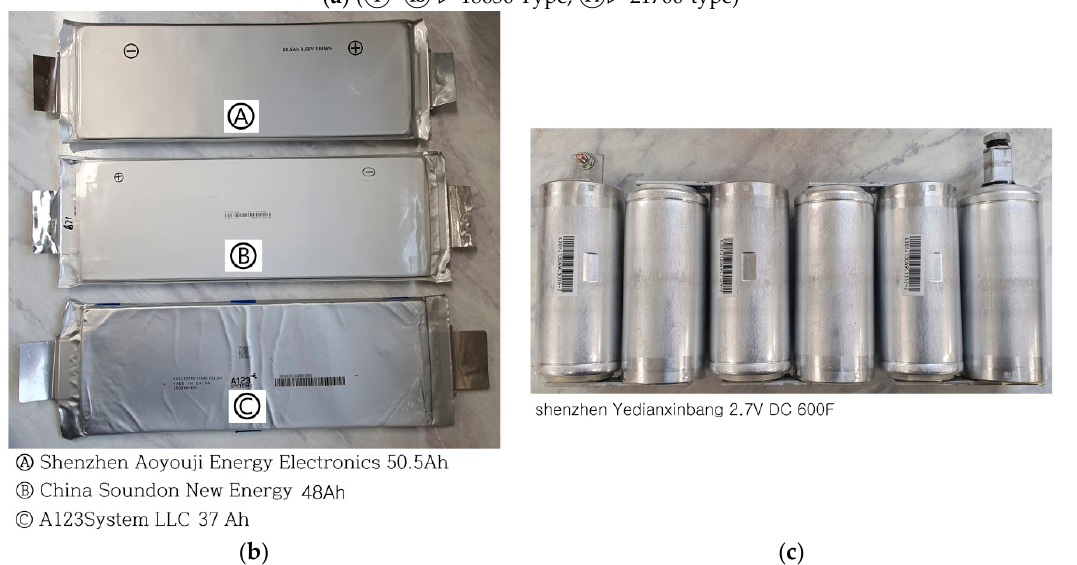
Figure 14. Li-ion batteries and supercapacitor used in the experiment. ( a ) Cylindrical Li-ion batteries: 18650-type—13 samples; 21700-type—1 sample; total of 14 samples. ( b ) Pouch-type Li-ion batteries: size 300 × 100 × 10 mm; total of 3 samples. ( c ) Supercapacitor: diameter 60 × height 140 mm; total of 1 sample.